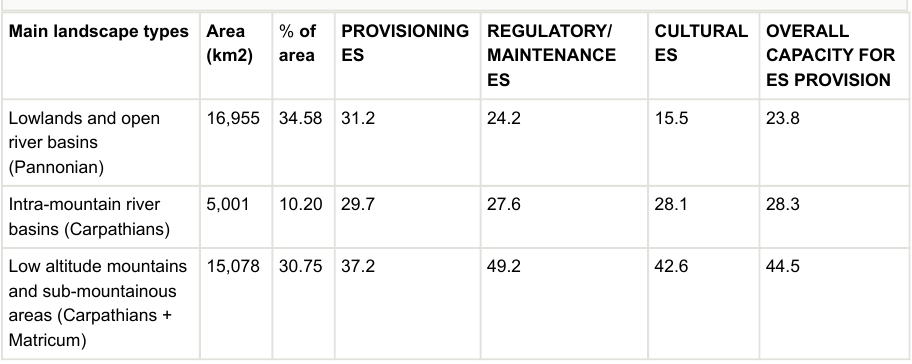
The capacity of the main landscape types of Slovakia for providing ecosystem services